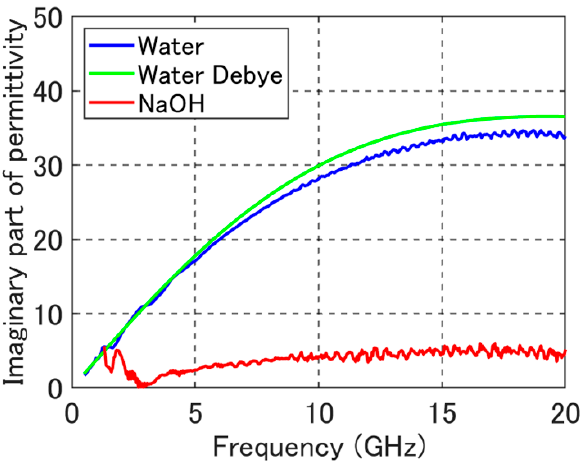
Figure 11. Estimated conductivity of the NaOH solution calculated by Equation (2).